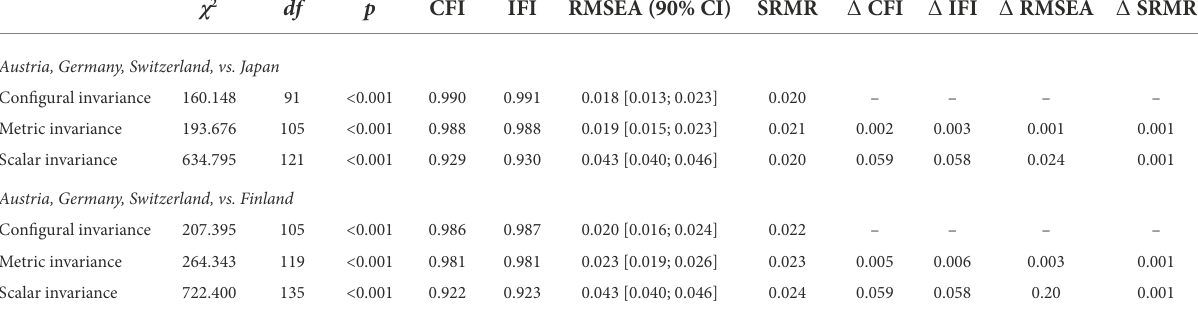
TABLE 5 Fit statistics for invariance tests across countries. χ 2